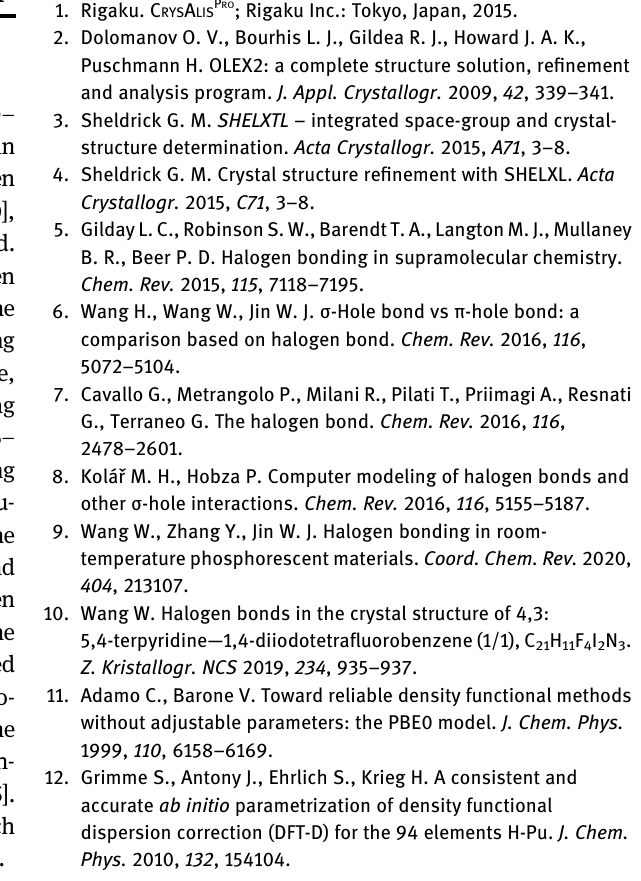
In conclusion, the 4,3 ′ :5 ′ ,4 ″ -terpyridine molecule only forms two strong halogen bonds with two 1,3-diiodo- tetrafluorobenzene molecules. The third electron-rich nitro- gen atom of 4,3 ′ :5 ′ ,4 ″ -terpyridine forms a hydrogen bond